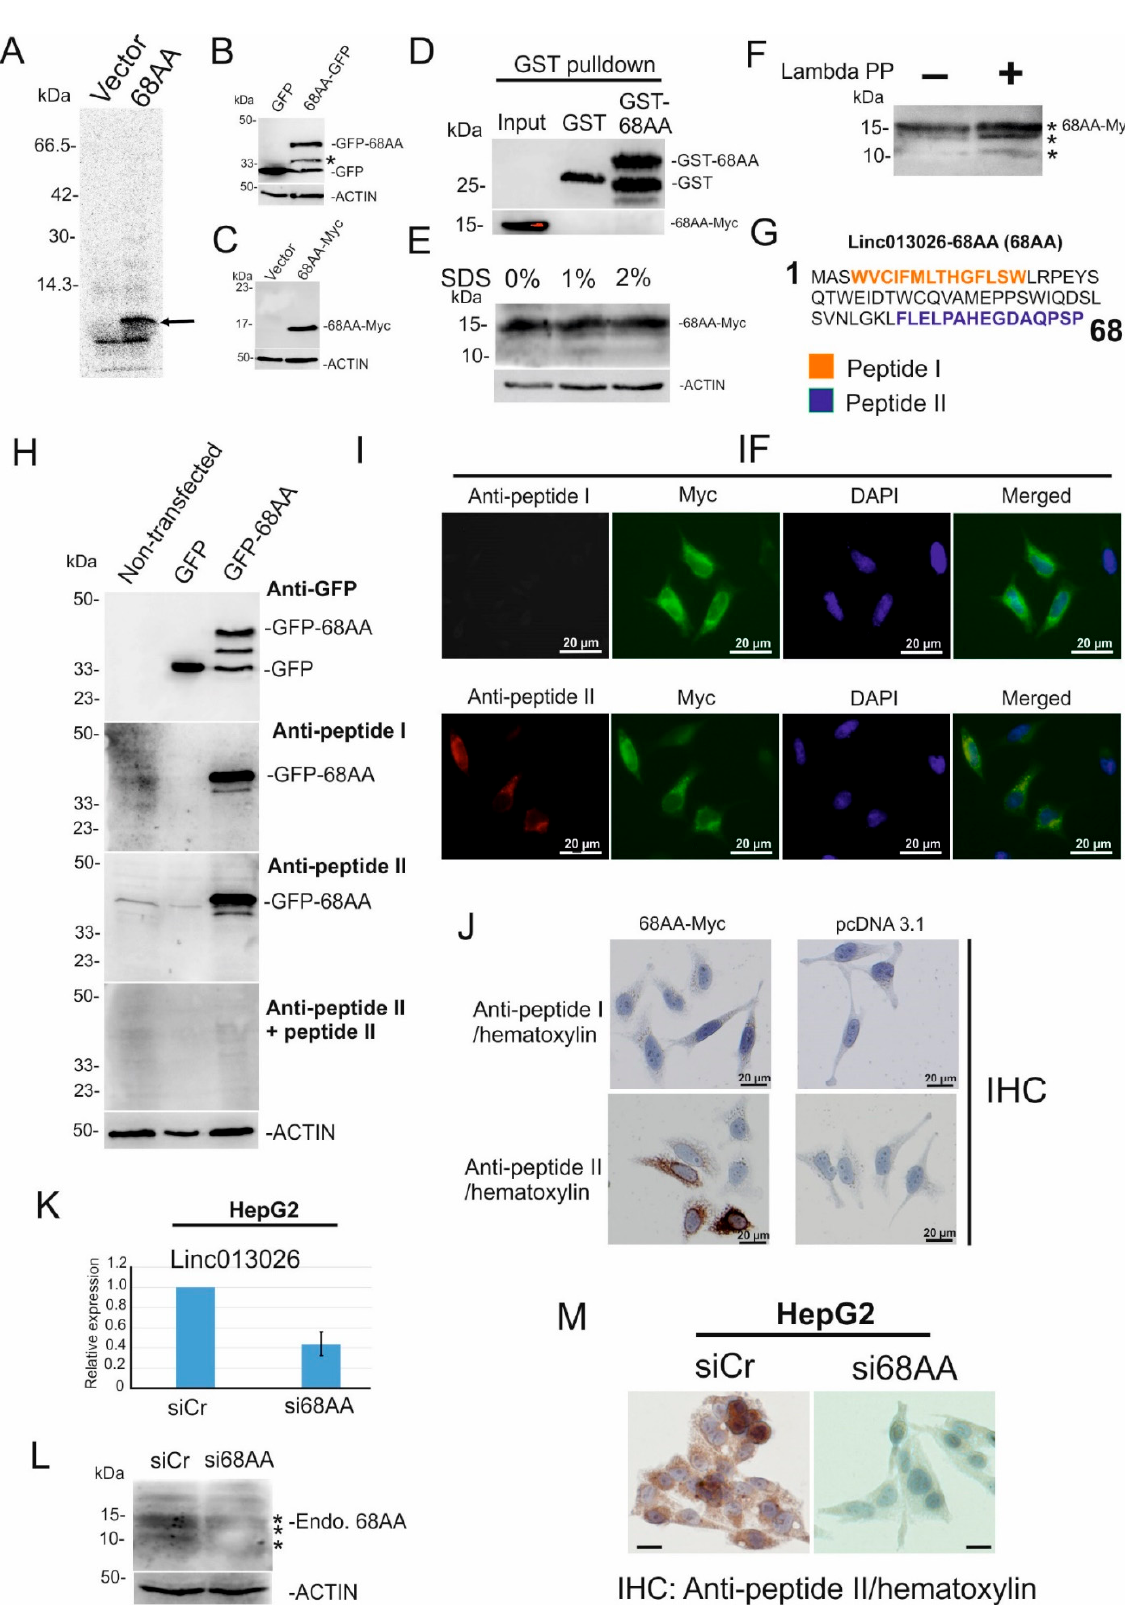
Figure 3. NONHSAT013026.2/Linc013026-68AA is translated into a 68 amino acid long micropep- tide. ( A ) In vitro transcription/translation assay of Linc013026-68AA, proteins are labeled with